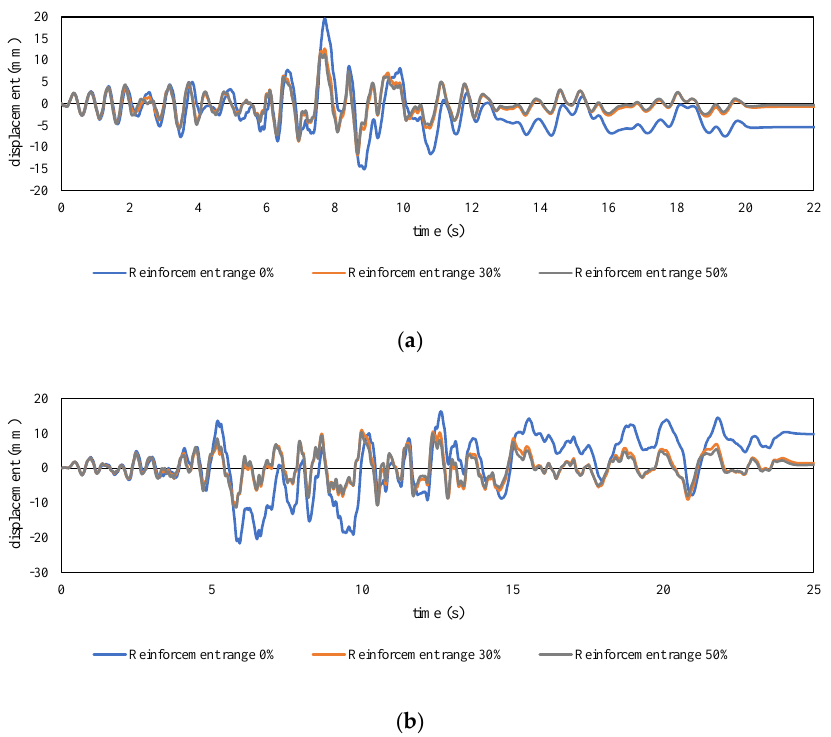
Figure 37. Comparison of displacement-time history at the top of the pier in TYPE-B’: ( a ) wave A; ( b ) wave B.